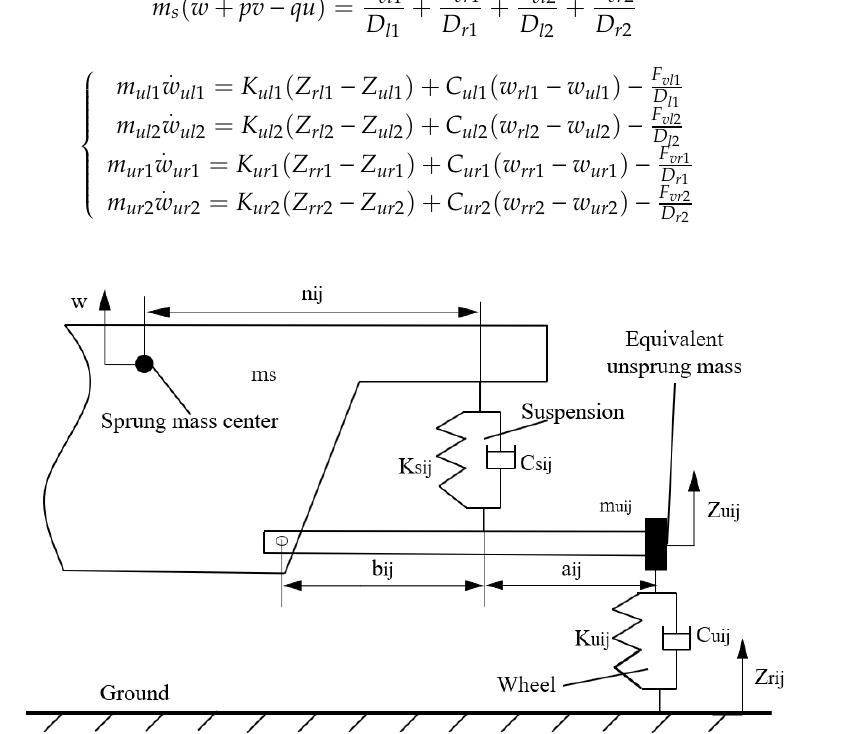
Figure 2. Suspension model. The unsprung mass of the suspension components and the wheels is replaced by an equivalent unsprung mass in this model.